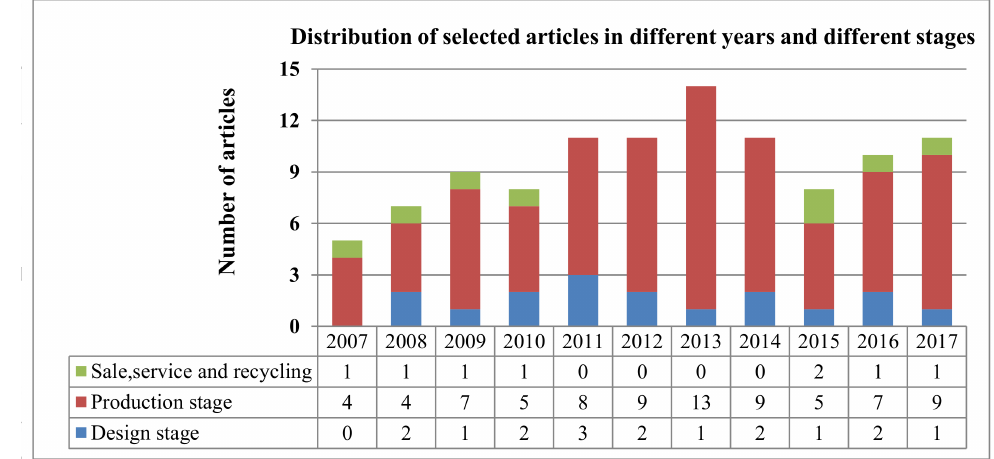
Figure 3. The distribution of selected articles in different years and different